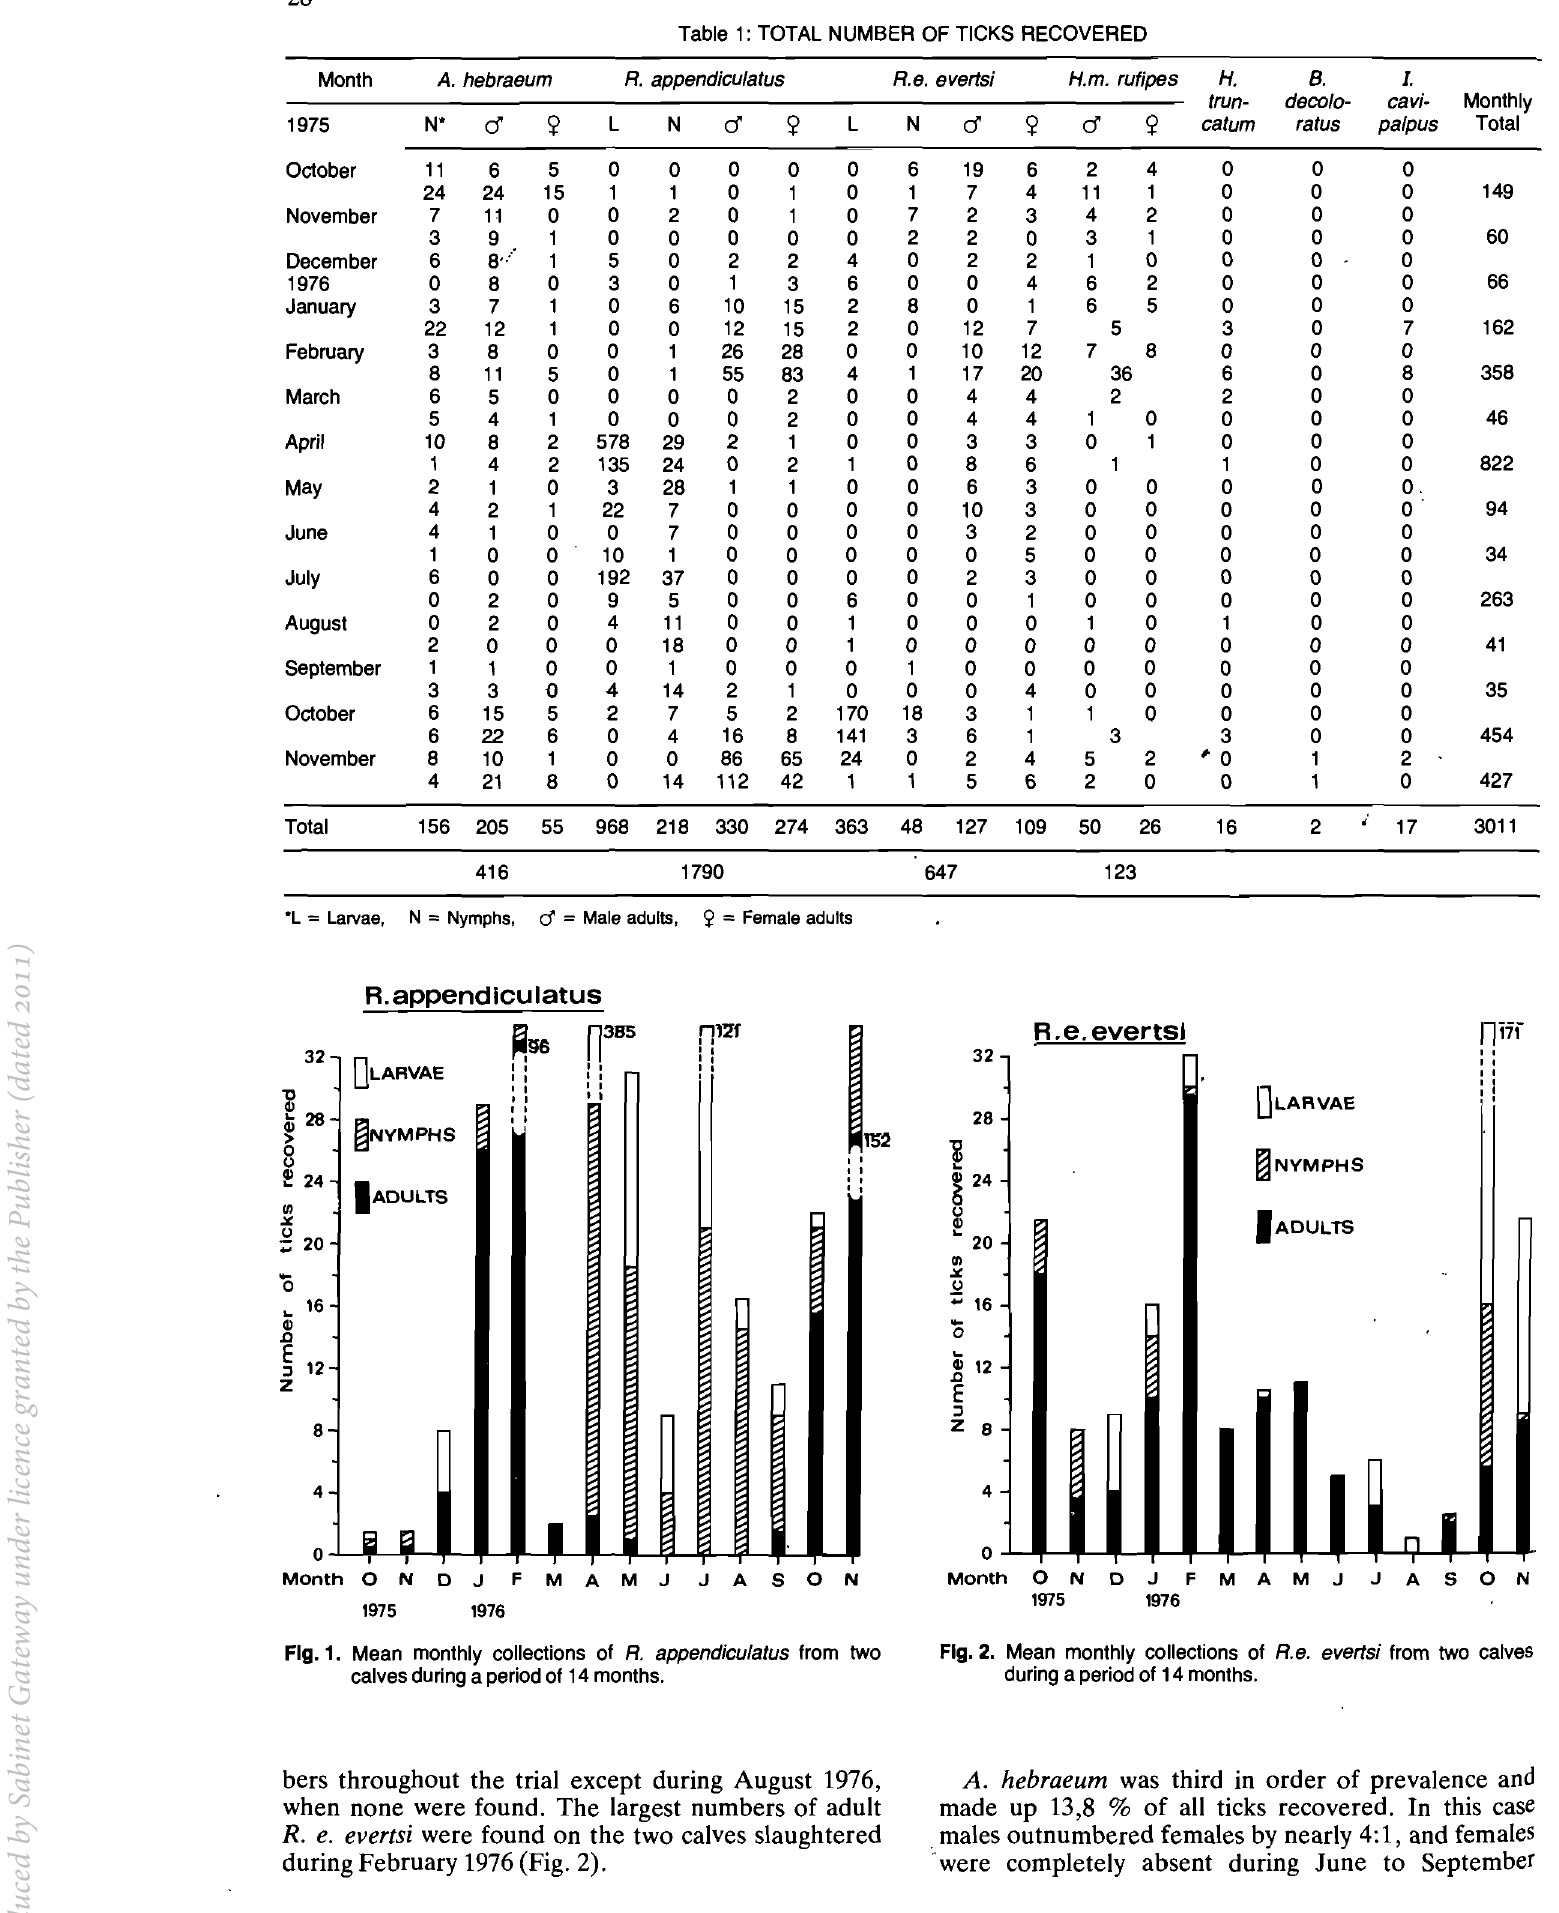
bers throughout the trial except during August 1976, when none were found. The largest numbers of adult R. e. evertsi were found on the two calves slaughtered during February 1976 (Fig. 2).